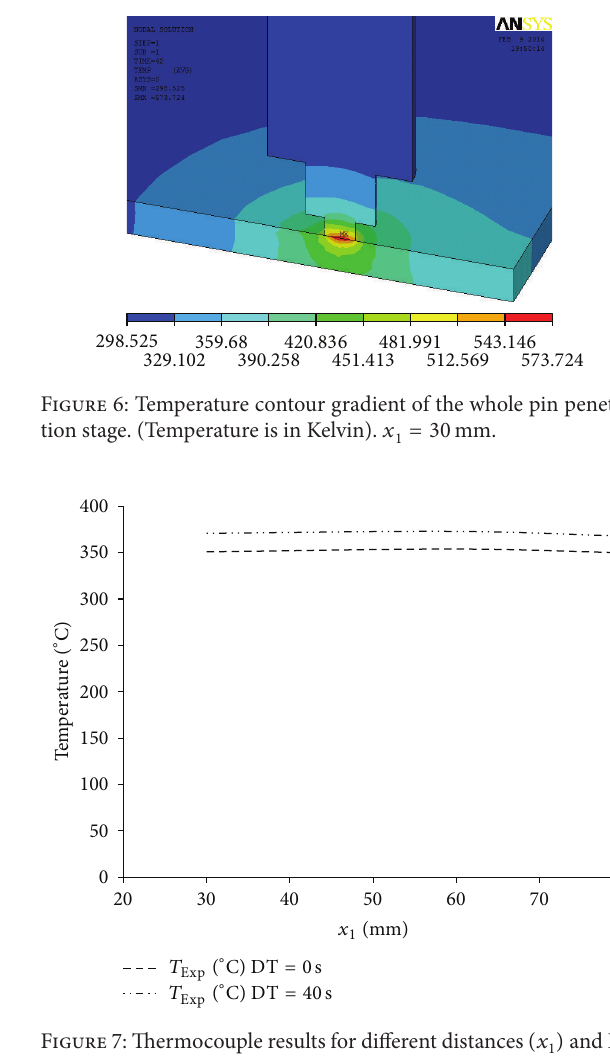
Figure 7: Thermocouple results for different distances (𝑥 1 ) and